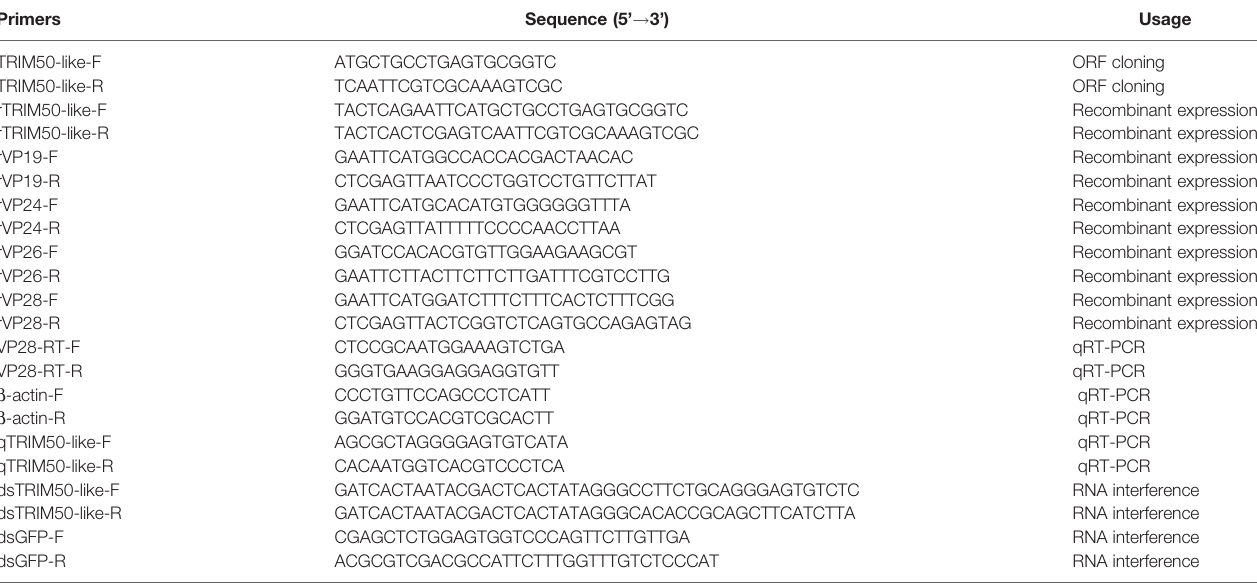
TABLE 1 | Primers used in this